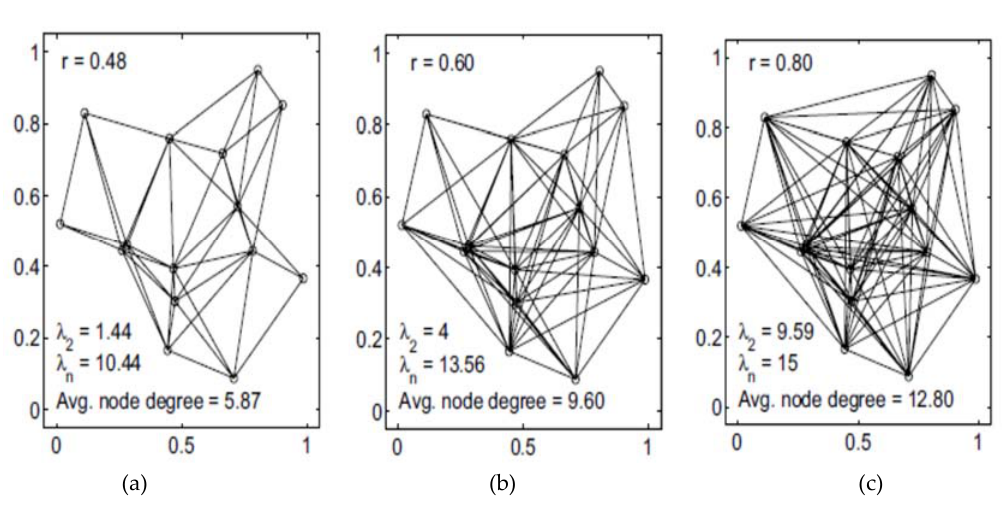
Figure 4. Nodes Realization, ( a ) For radius = 0.48, ( b ) For radius = 0.6, ( c ) For radius = 0.8 [19].